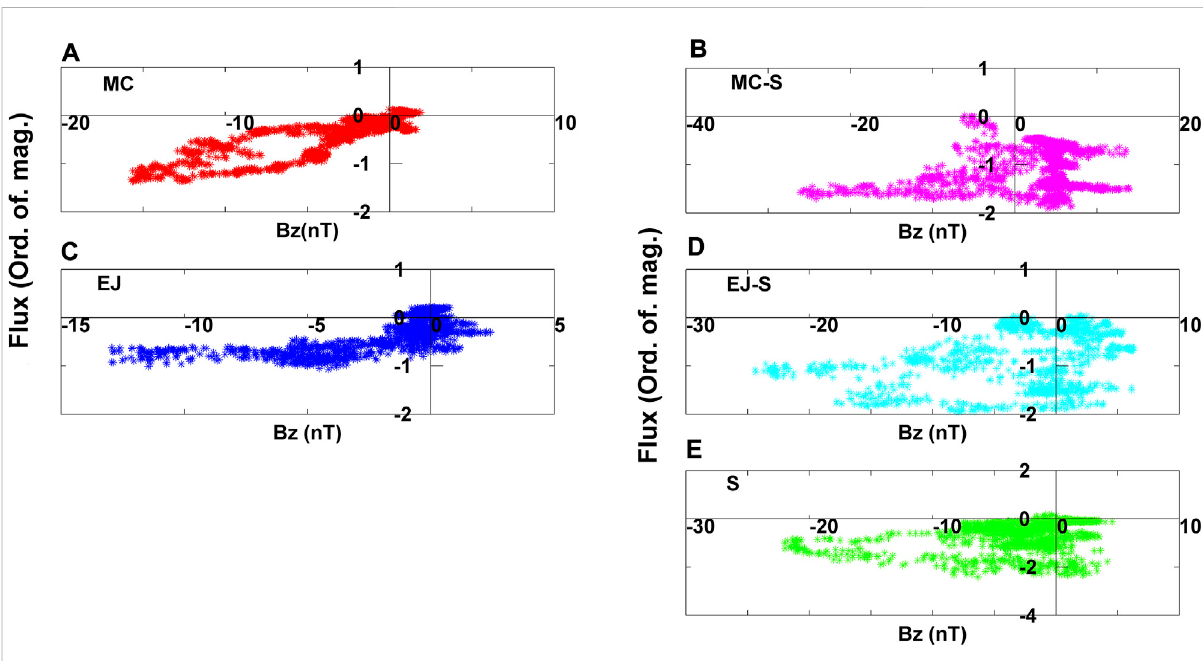
FIGURE 7 Variation of Δ F (in the order of magnitude) with IMF Bz (nT) for storms associated with (A) MC, (B) MC-S, (C) EJ, (D) EJ-S, and (E) S.